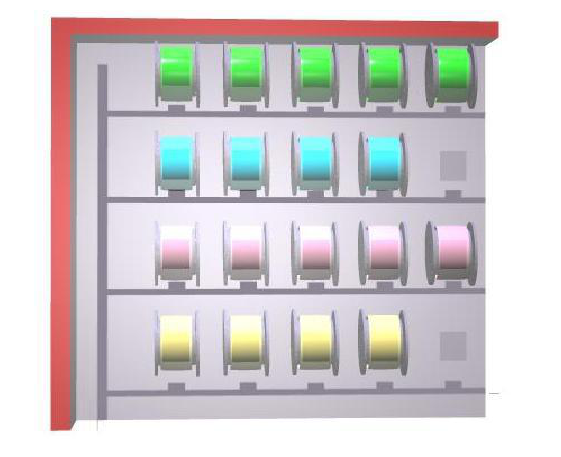
Figure 3: A partial view of the mechanical part. The top is covered with a double glass pane for illustration purposes (the voter’s actual view is shown in figure 4). Notice that the figure displays four races; the first and the third race contain five candidates each; whereas, the second and fourth races contain four candidates